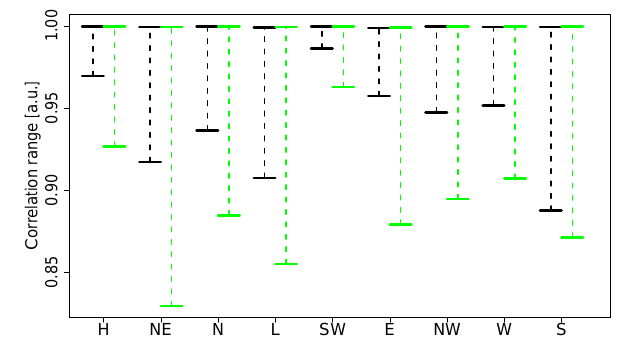
Figure 8. Range of correlation values achieved by training the up- scaling for the specific CWTs (black) and from training over all time steps (green).